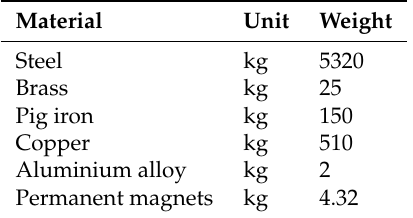
Table 3. Summary of the mass streams of the ORC